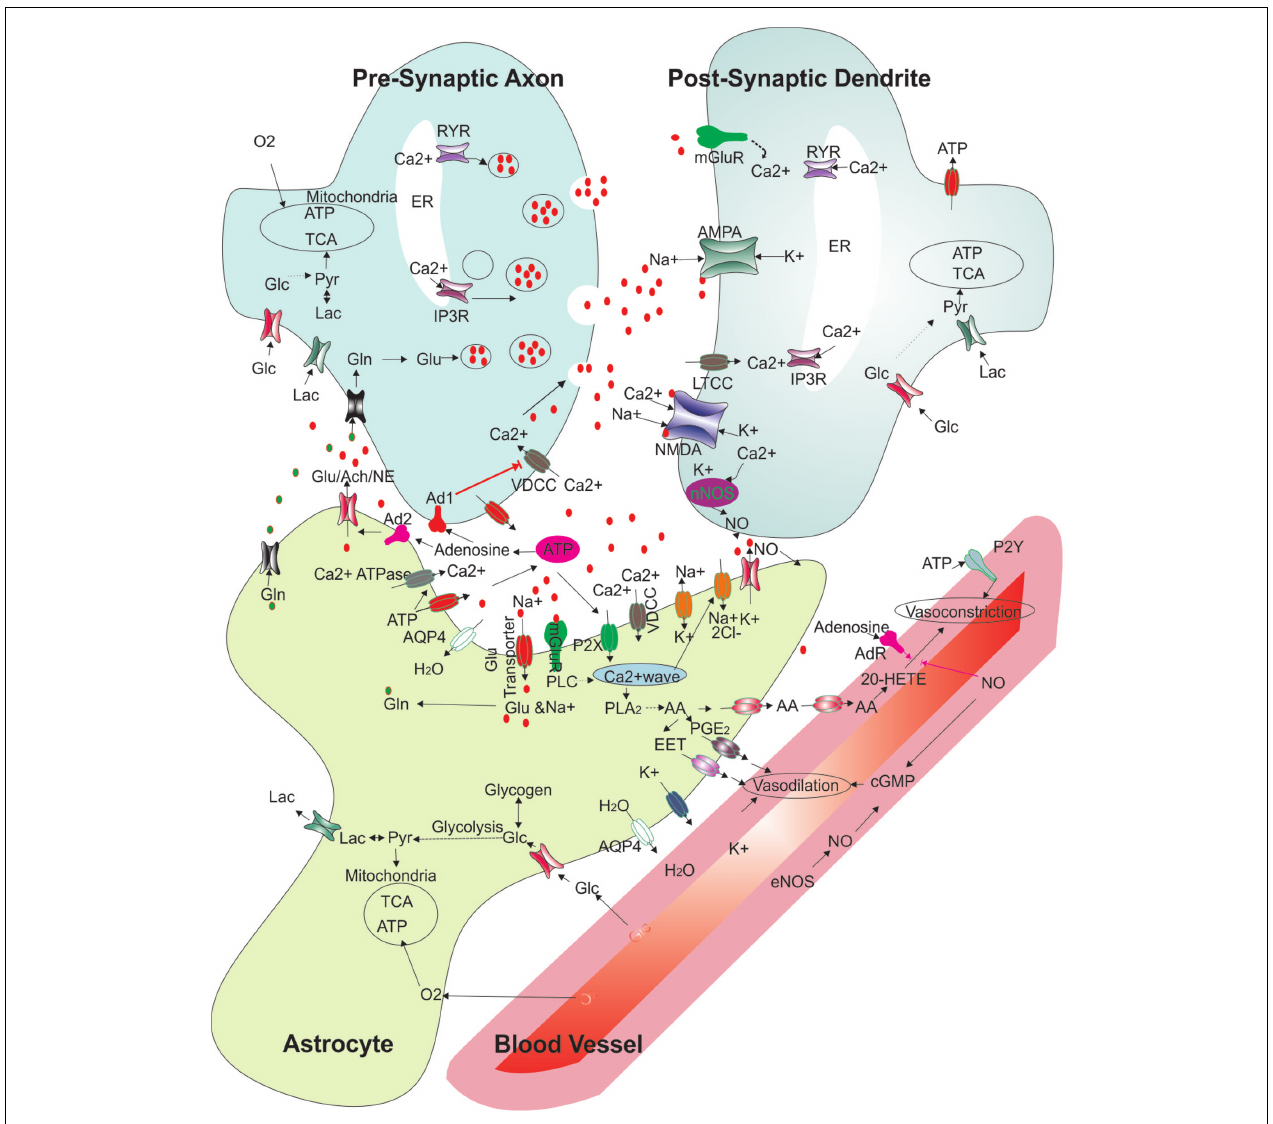
phosphate; Ach, acetyl choline; NE, norepinephrine; No, nitric oxide; Ad1, adenosine receptor 1; Ad2, adenosine receptor 2; mGluR, metabotropic glutamate receptor; NMDAR, N-methyl-D-aspartic acid receptor; AMPAR, 2-amino-3-(5-methyl-3-oxo-1;2- oxazol-4-yl)propanoic acid receptor; nNOS, neuronal nitric oxide synthase; eNOS, endothelial nitric oxide synthase EET, epoxyeicosatrienoic acids; AA, arachidonic acid; PGE2, prostaglandin 2; 20-HETE, 20-hydroxy arachidonic acid; PLA2, phospholipase A2; cGMP,cyclic guanosine monophosphate; P2X; purinergicreceptor P2X; P2Y, purinergic receptor P2Y; PLC, phospholipase C; AQP4, aquaporin-4;VDCC, voltage dependent calcium channel; LTCC, L-type calcium